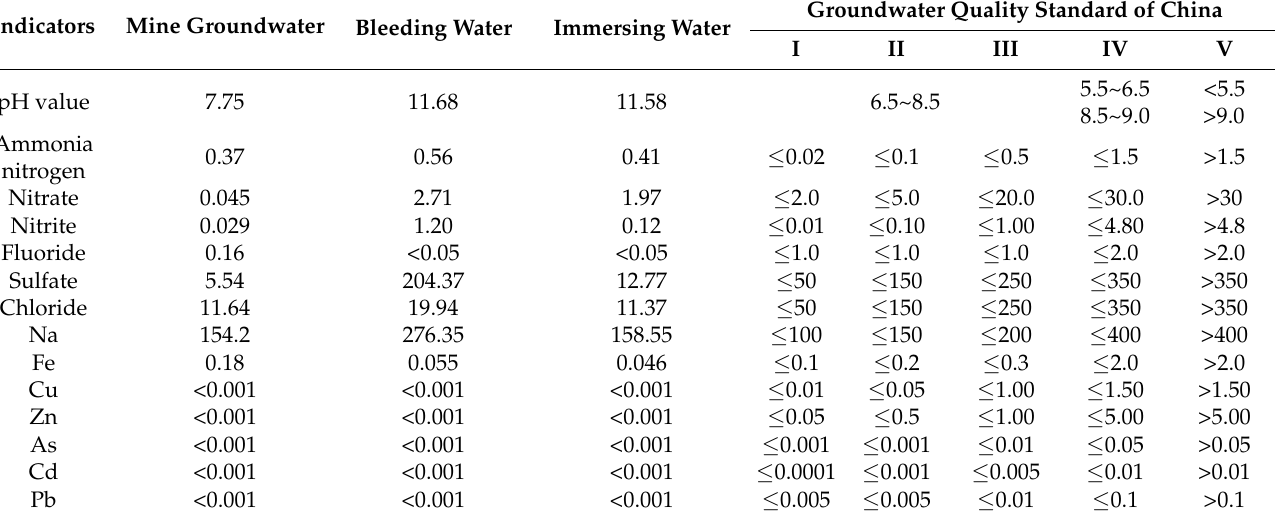
Table 2. Results of bleeding and immersion tests (unit: